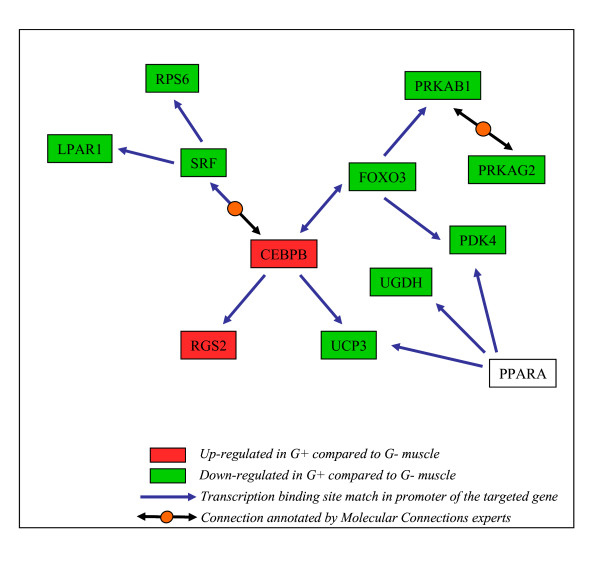
Summary of interactions between genes differentially expressed between G+ and G- muscles evidenced through a promoter analysis. Genes highlighted in red and green were up- and down-regulated in G+ compared to G- muscle, respectively. Gene names are indicated in capitals according to Gene Ontology. PPARA, Peroxisome proliferator-activated receptor alpha. Expression of PPARA was not measured in the present study. See Table 3 for other gene names.